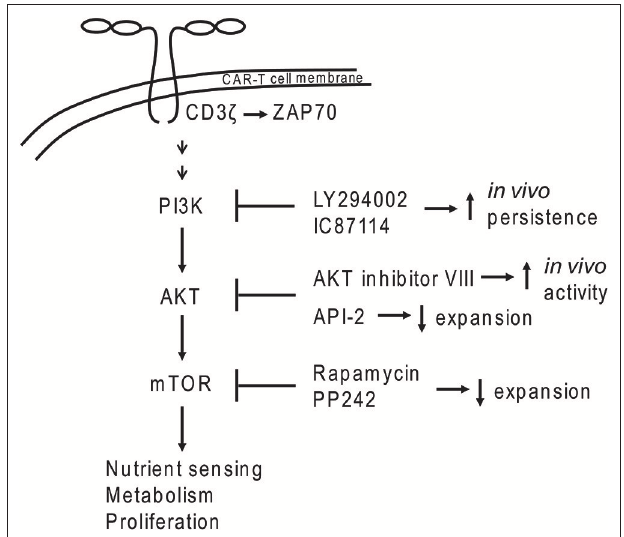
FIGURE 1 | PI3K-AKT-mTOR signaling in CAR-T cells. Dimerization of CAR molecules mimics T cell receptor activation of the PI3K signal transduction cascade. Application of some inhibitors (e.g., PI3K inhibitors LY294002 and IC87114 or the AKT inhibitor VIII) during ex vivo expansion led to increased in vivo persistence of CAR-T cells.